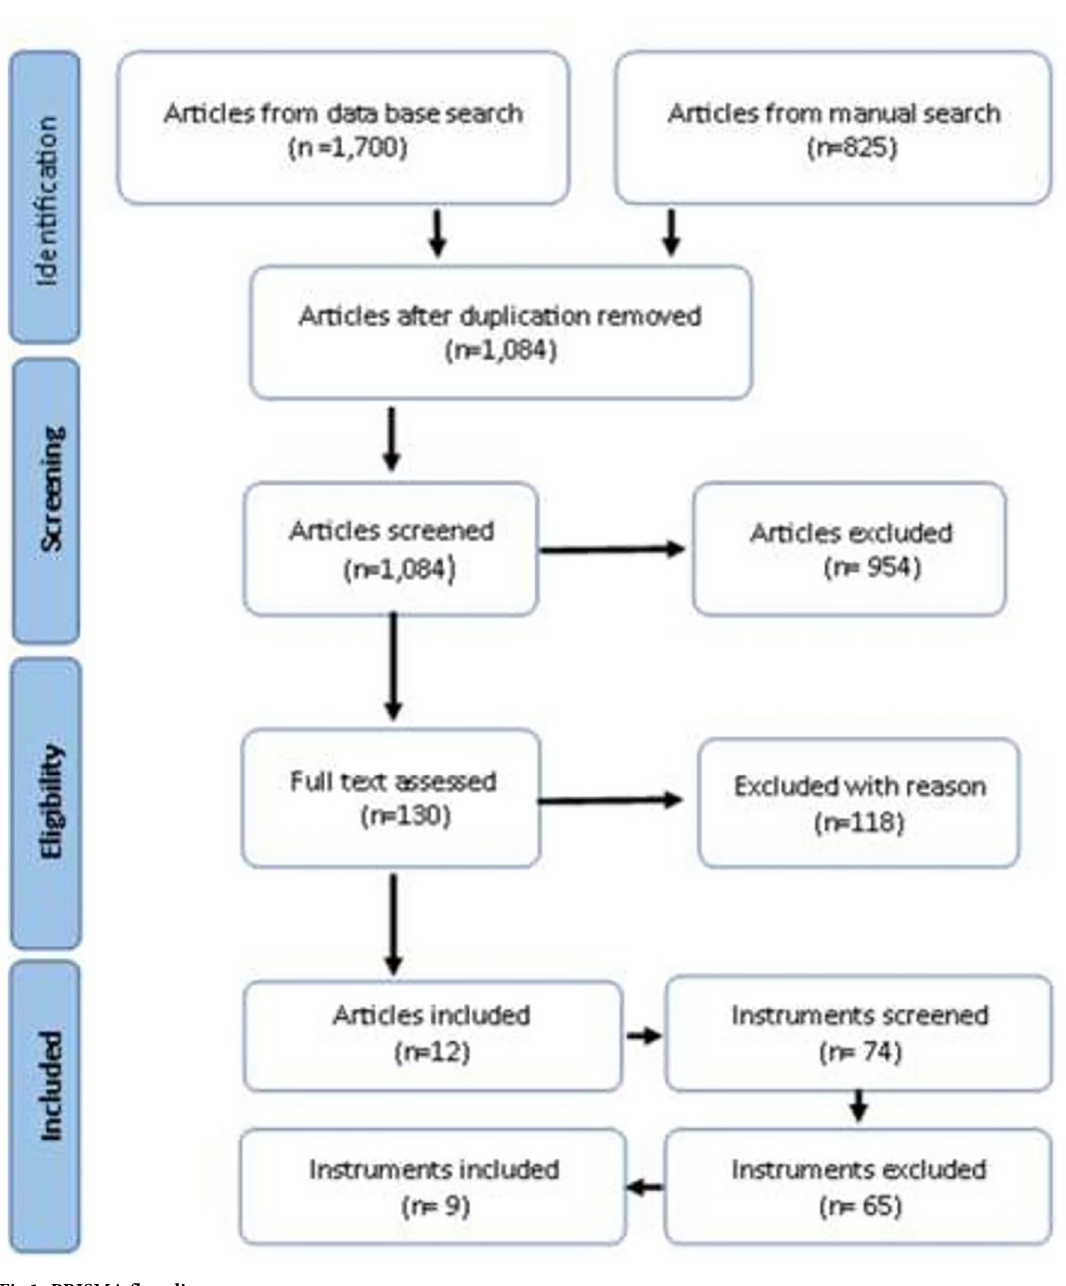
Fig 1. PRISMA flow